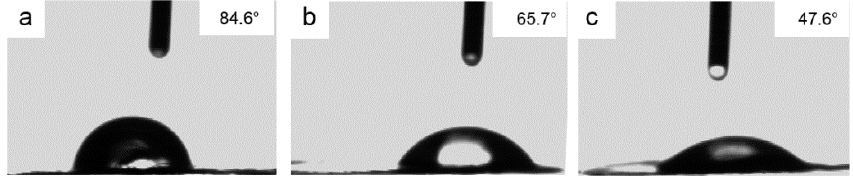
Figure 7. Contact angle (CA) images of deionized water droplets on the surface of the ( a ) PBO-Pre, ( b ) PBO-APTES, and ( c ) PBO-La fibers.